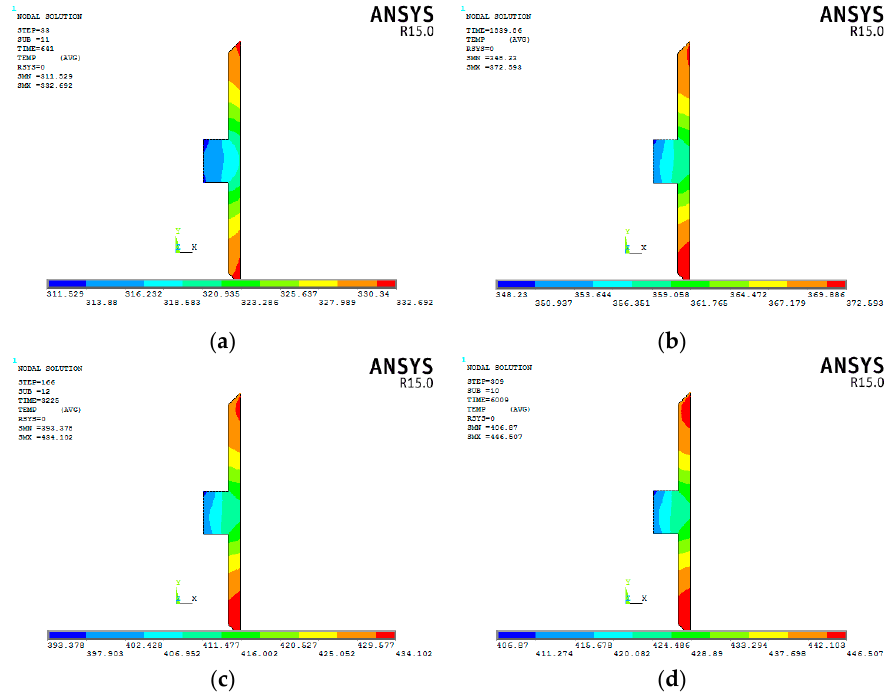
Figure 17. Temperature field of EMRG after: ( a ) 641 s, ( b ) 1840 s, ( c ) 3225 s, and ( d ) 6000 s.